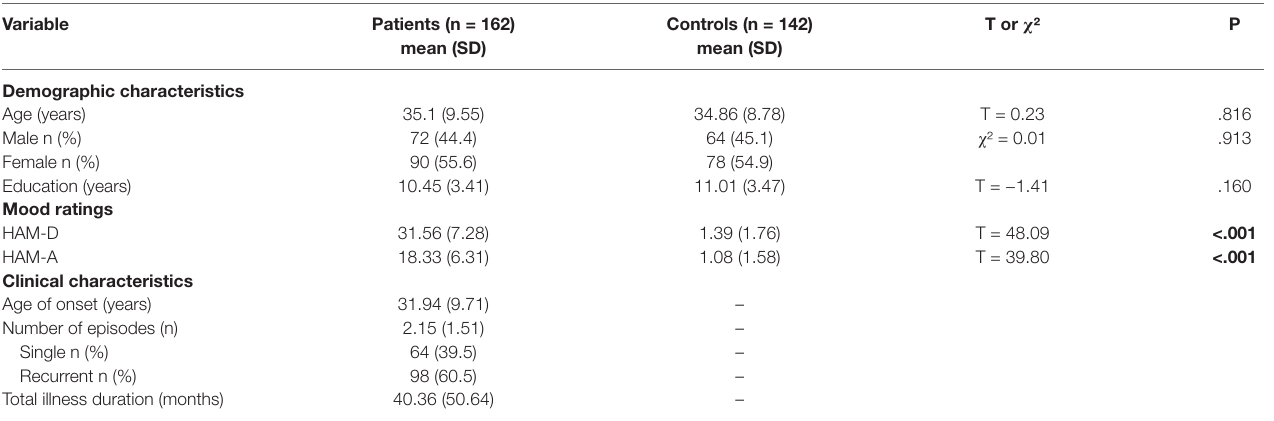
TaBlE 1 | Demographic and clinical characteristics of MDD and HC groups.